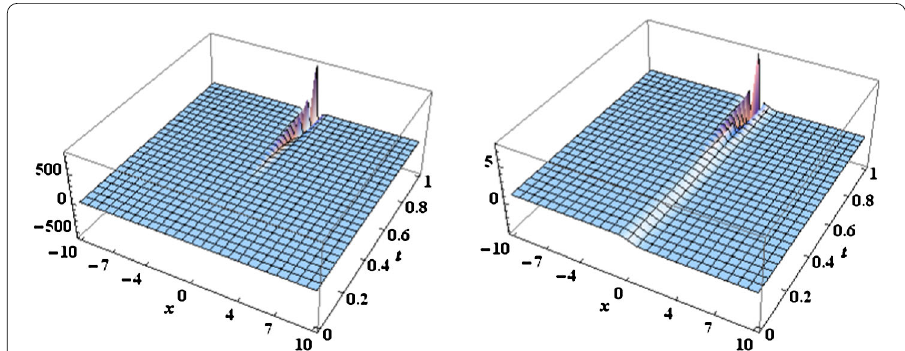
Figure 1 The approximate solutions for Example 4.1 when α = 0.25, α = 0.5, α = 0.75 and α = 0.90,